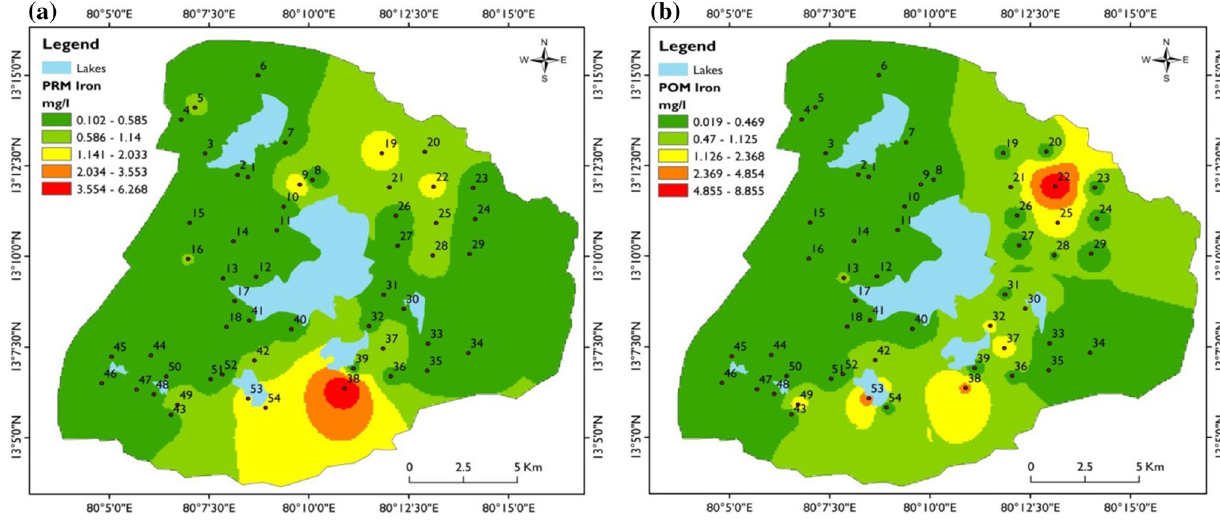
Fig. 3 a , b Spatial variation of iron in the groundwater for pre-monsoon and post-monsoon,